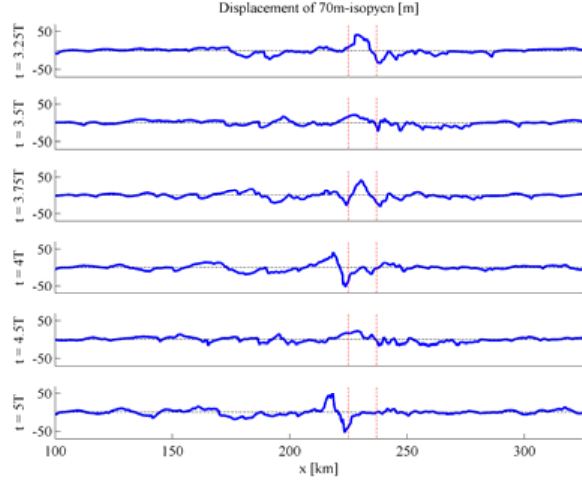
Fig. 7. Displacement of 70m isopycn for different times. Figure 7. Displacement of 70 m isopycn for different times 4 Results of the modeling The calculated density fields (left) and total (barotropic and baroclinic) horizontal velocity values (right) are shown in Fig. 5 for various tidal phases. Normalized density ( ρ − ρ 0 ) /1000 is given, where ρ is sea water density [kg m − 3